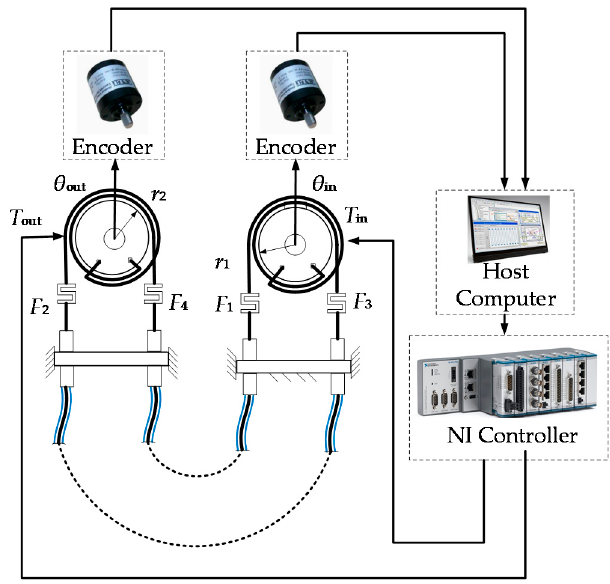
Figure 3. Overall block diagram of the control system.